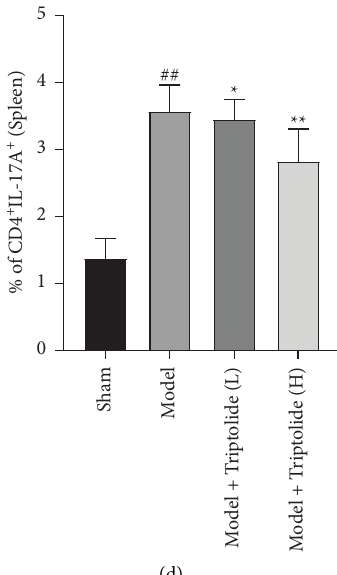
Figure 5: Infuences of triptolide on T17 cells in psoriatic mice induced by IMQ. On the 8 th day after triptolide treatment, isolation of draining LN and spleen cells from mouse models in the indicated groups was performed. (a–d) Flow cytometry analysis used to analyze the cells for determining the percentages of IL-17A-expressing cells within the CD4 + population. Histograms are gated on the CD4 + population. Each column is representative of data obtained from a minimum of 8 animals. ## P < 0 . 01 compared to the sham group; ∗ P < 0 . 05, ∗∗ P < 0 . 01 compared to the model